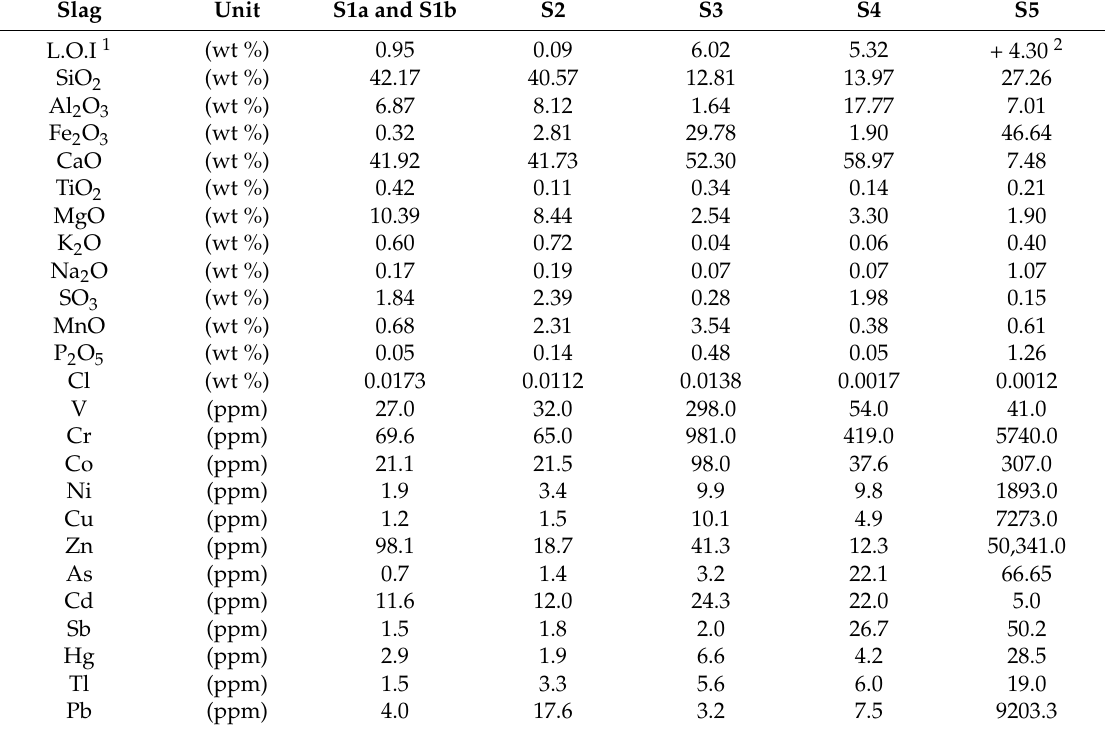
Table 1. The chemical composition (semi-quantitative analysis) of the tested metallurgical slags.